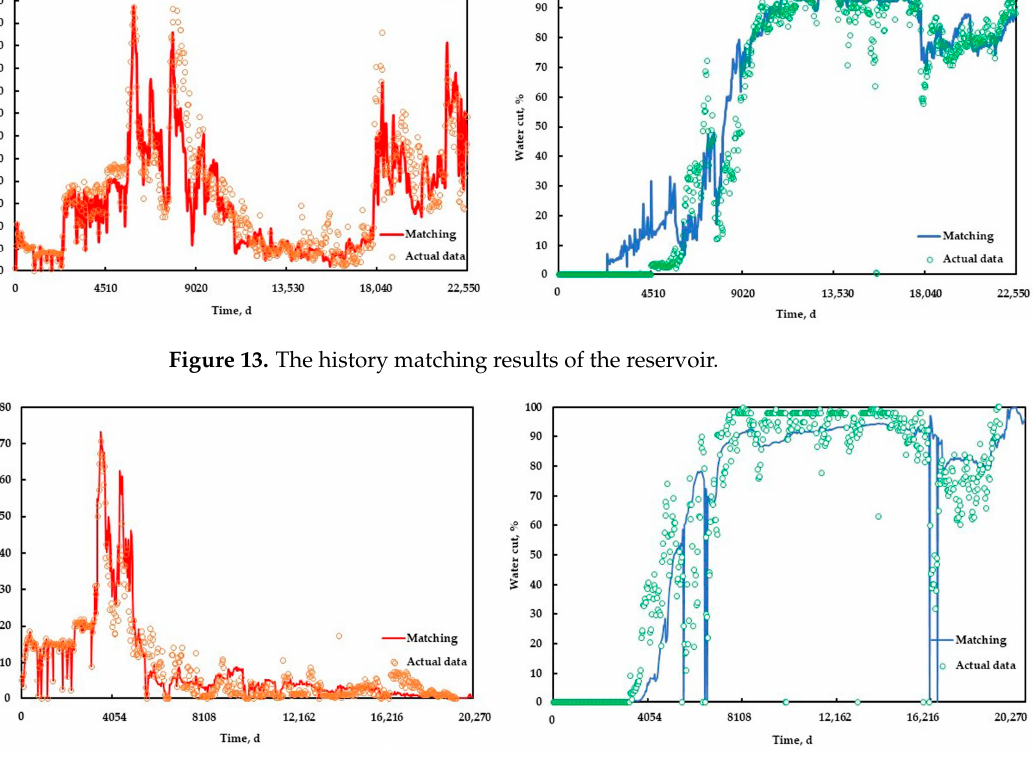
Figure 14. The history matching results of the typical single well. Table 6. Parameter design of gel